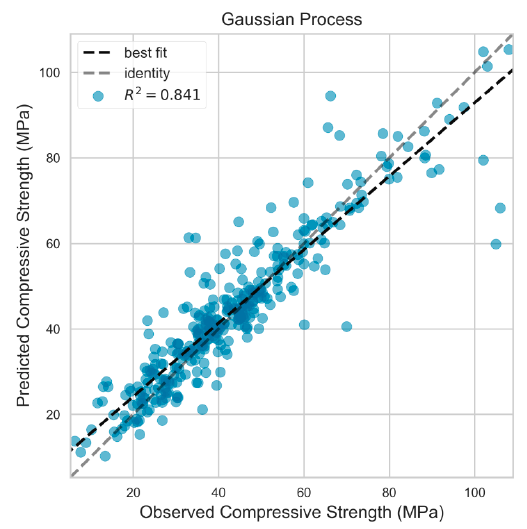
Table 12. Measured performance of deep learning model.